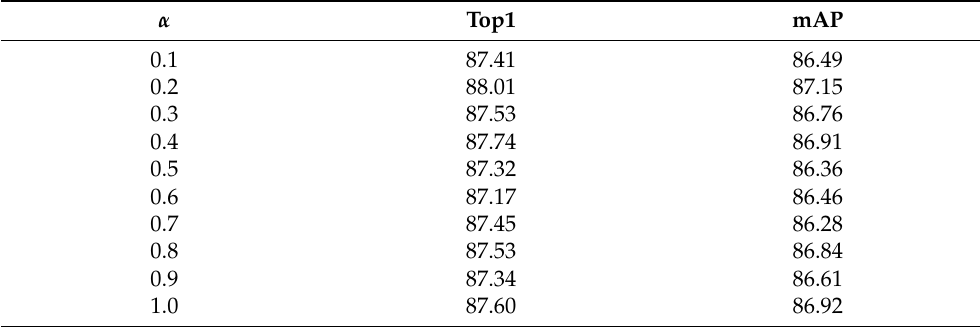
Table 7. Mineral recognition results based on fused features and weighted top- k loss when k = 0.5 (%). α